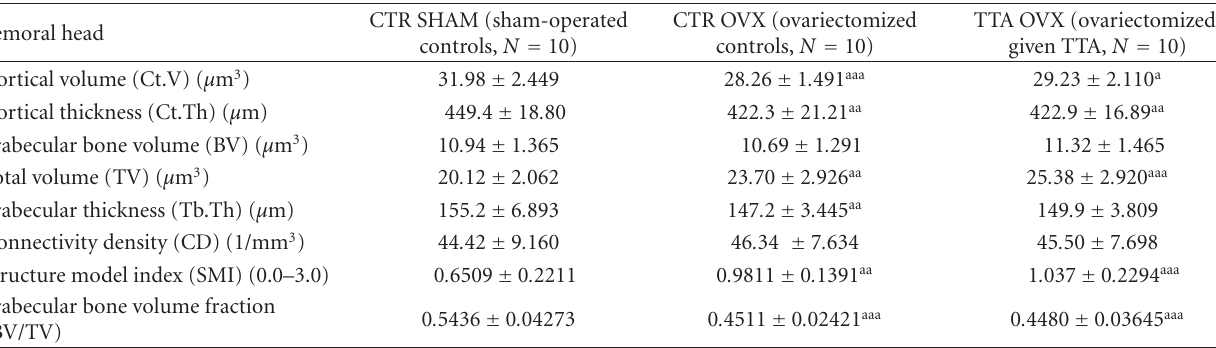
Table 5: Mean values ± SD of bone architecture parameters in the femoral head, determined by means of μ CT scanning analyses in sham controls, ovariectomized controls, and ovariectomized rats fed TTA for four months (Study II). Femoral